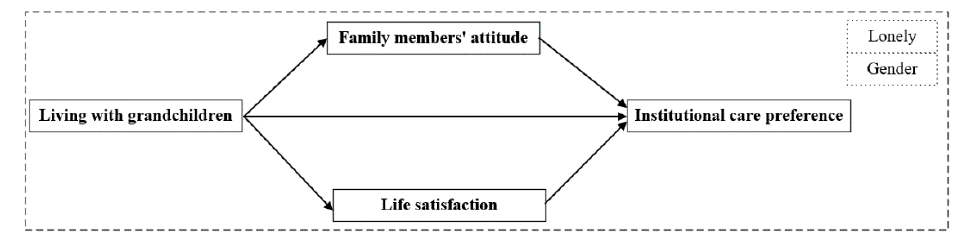
Figure 1. Proposed model of the study.